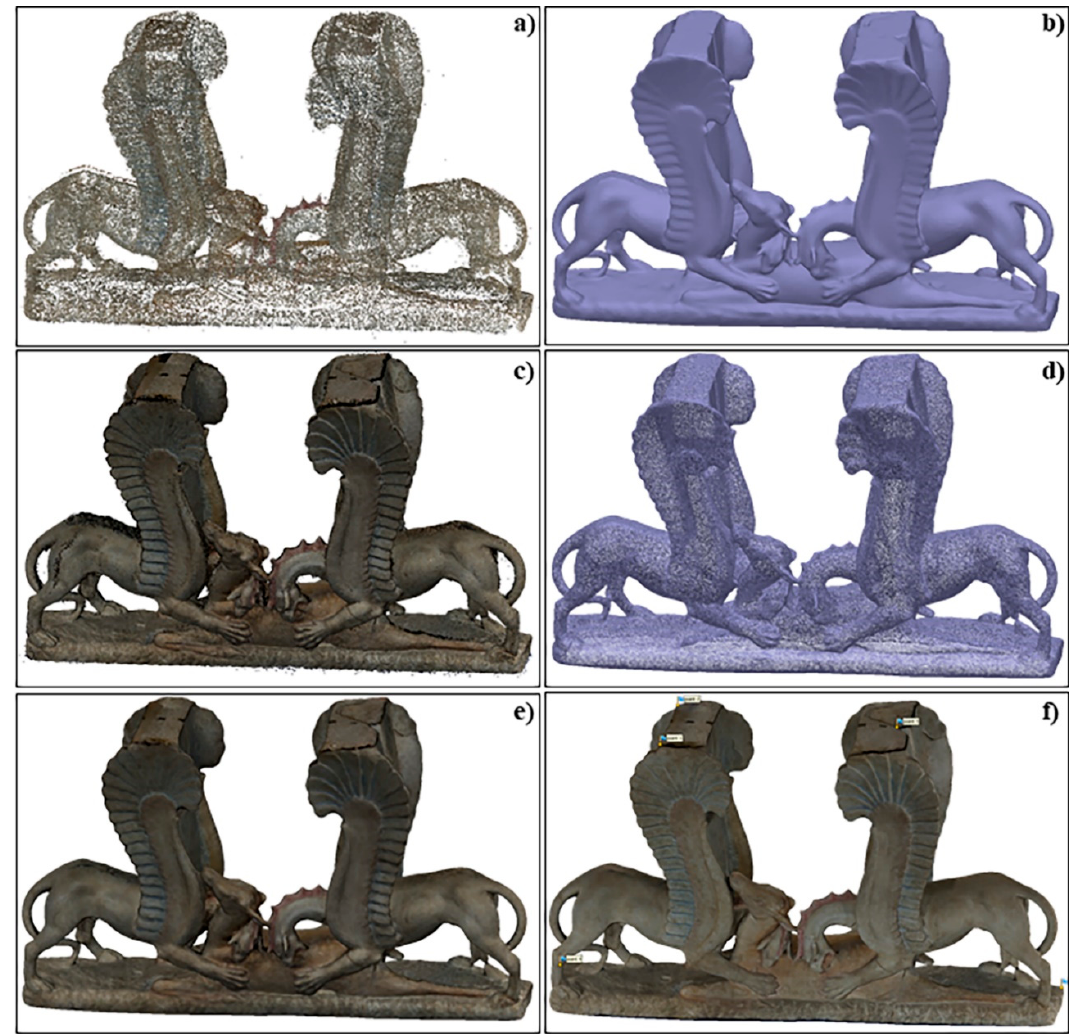
Figure 2. Sparse point cloud ( a ), dense cloud ( b ), mesh RGB ( c ), solid mesh ( d ), wireframe mesh ( e ), and texture with ground control points (GCPs) ( f ).